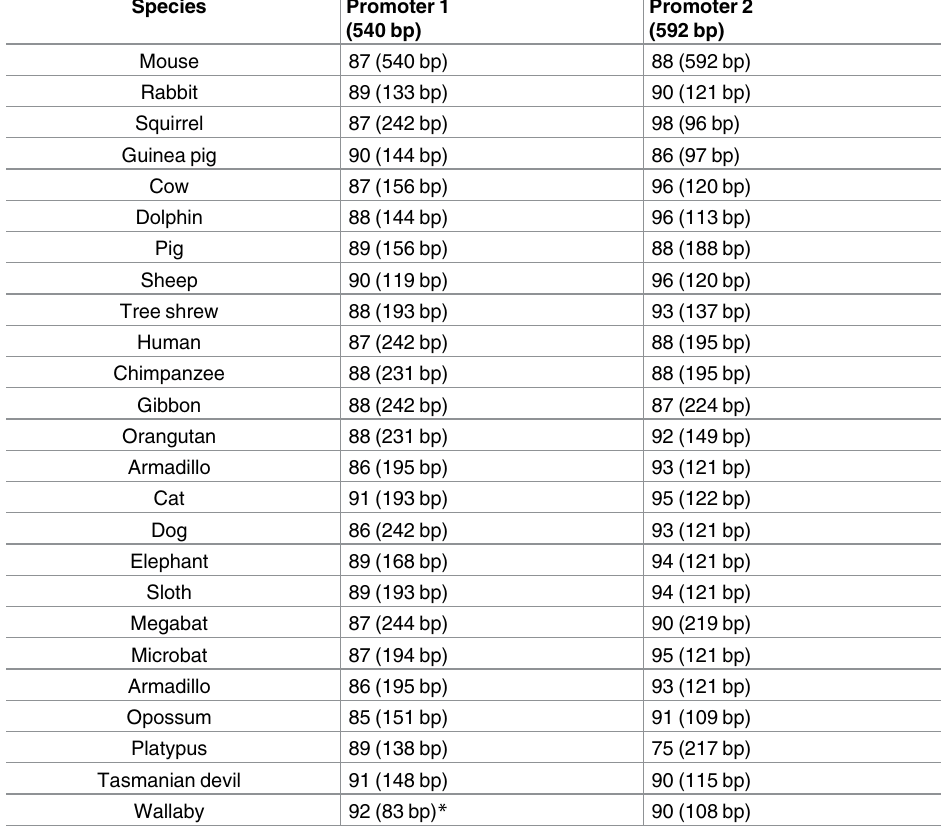
Table 3. Nucleotide identity with rat Igf1 promoters